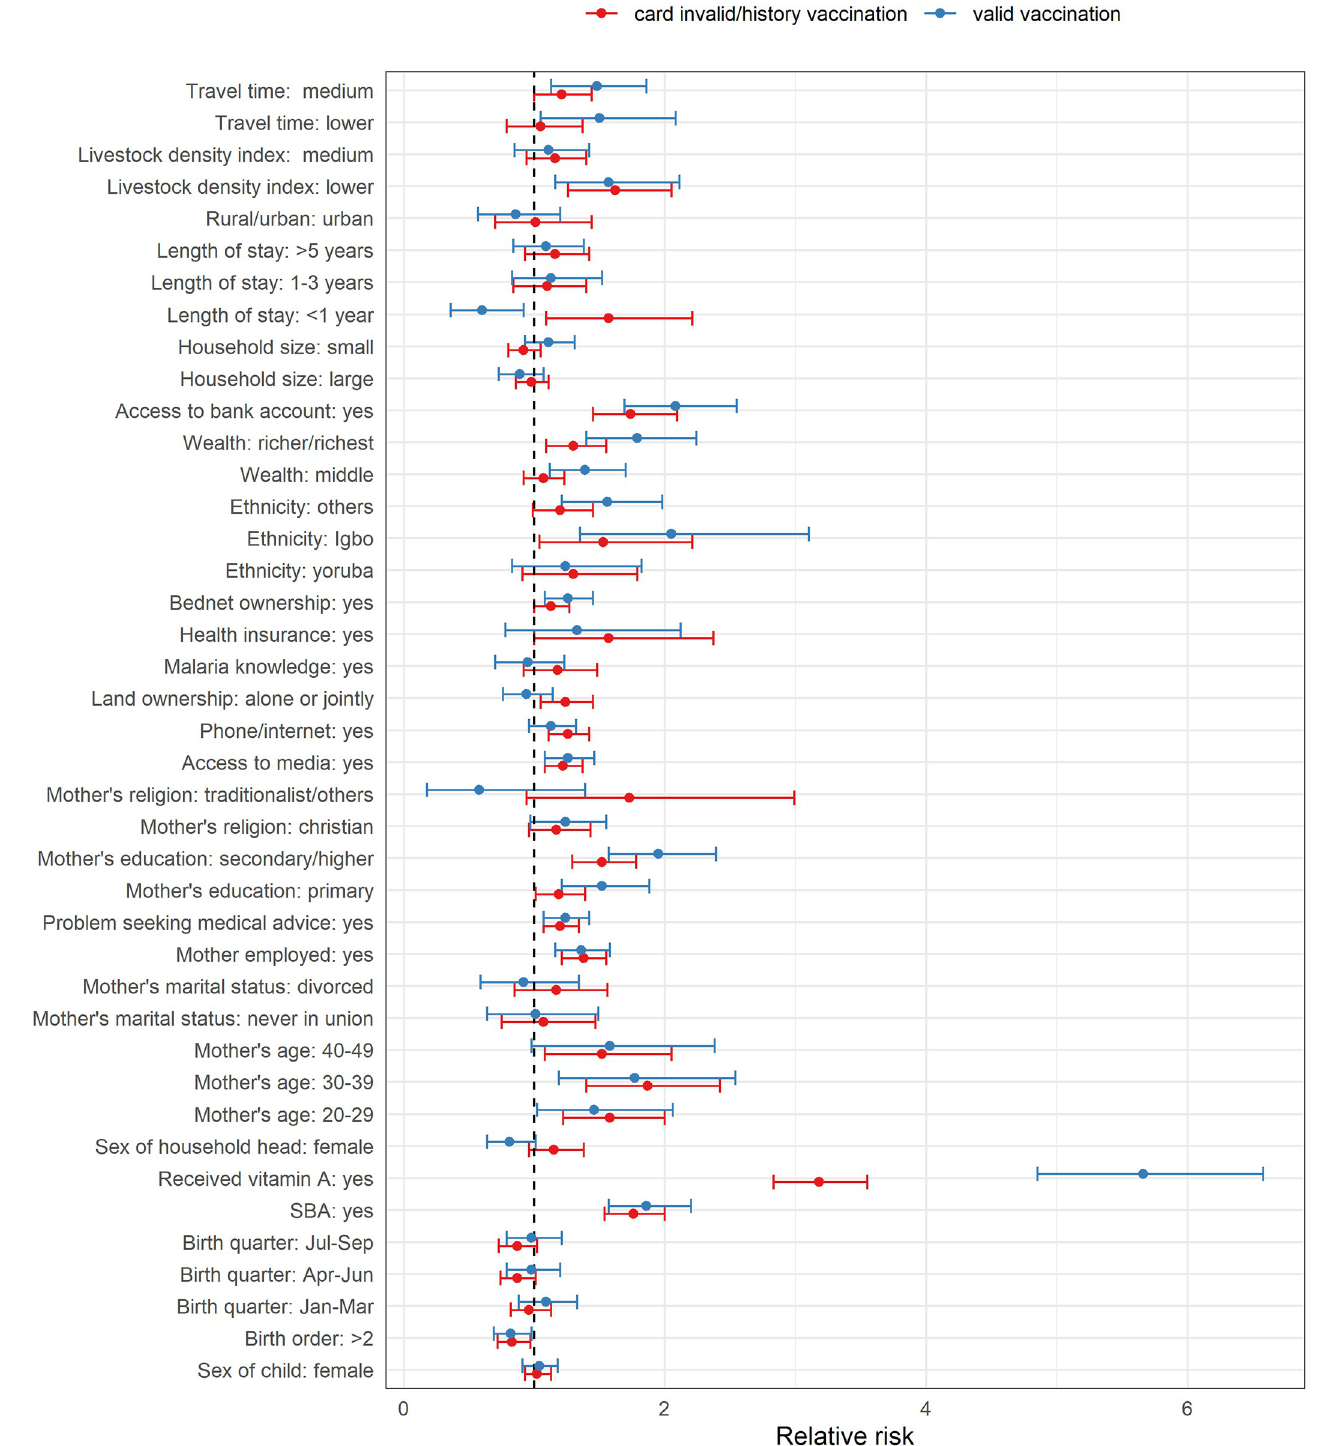
Fig 5. Plots of relative risks and corresponding 95% credible interval based on Bayesian multilevel multinomial analysis for MV vaccination coverage. The vertical dotted line marks the relative risk of 1.